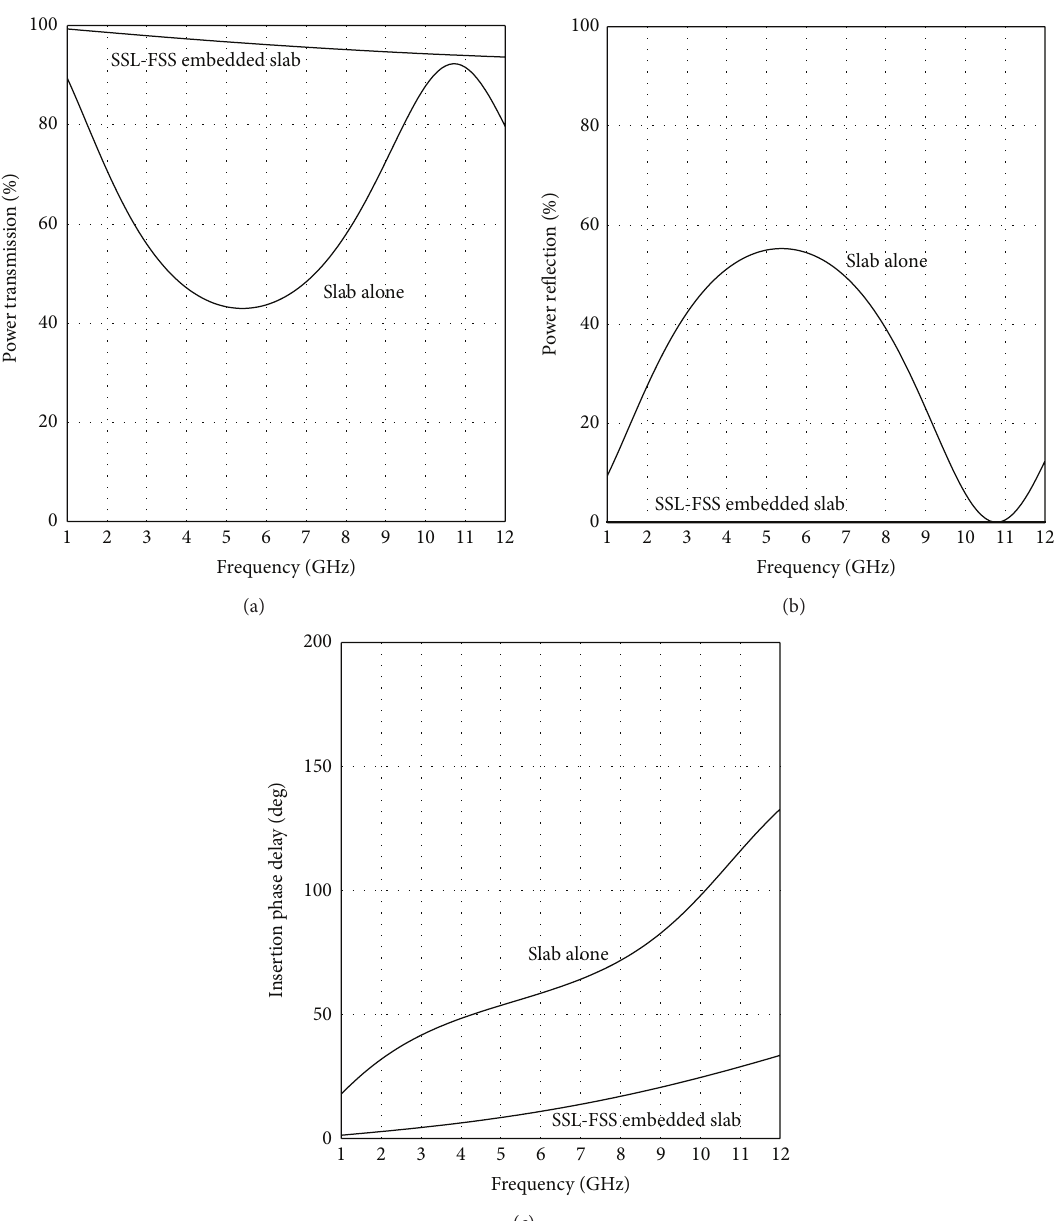
Figure 5: (a) SSL-FSS embedded monolithic half-wave slab design results in higher power transmission characteristics at 45 ∘ over a broadband (1GHz–12 GHz) as compared to the slab alone case. (b) SSL-FSS embedded monolithic half-wave slab design results in lower power reflection characteristics at 45 ∘ over a broadband (1GHz–12 GHz) as compared to the slab alone case. (c) SSL-FSS embedded monolithic half-wave slab design results in superior insertion phase delay characteristics at 45 ∘ over a broadband (1GHz–12 GHz) as compared to the slab alone